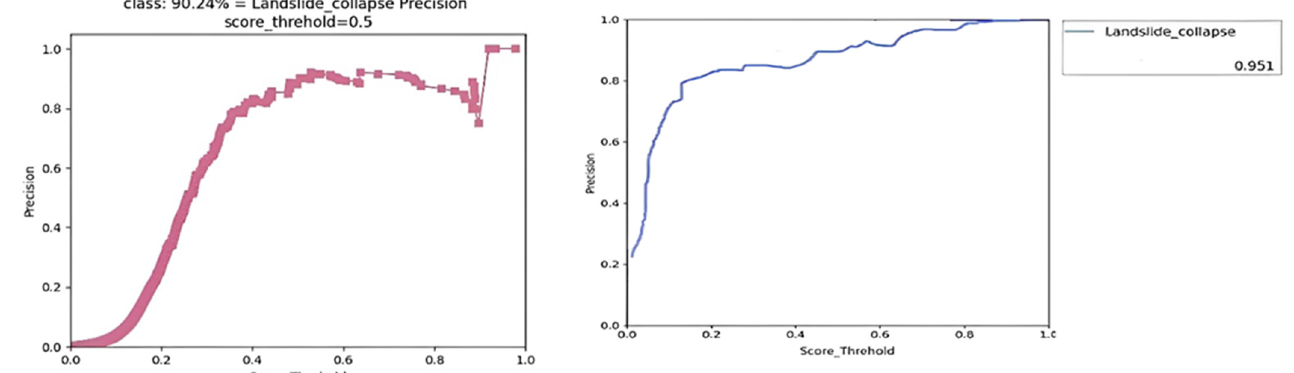
Figure 11. The precision of the SSD model ( left ) and the transfer learning model ( right ).